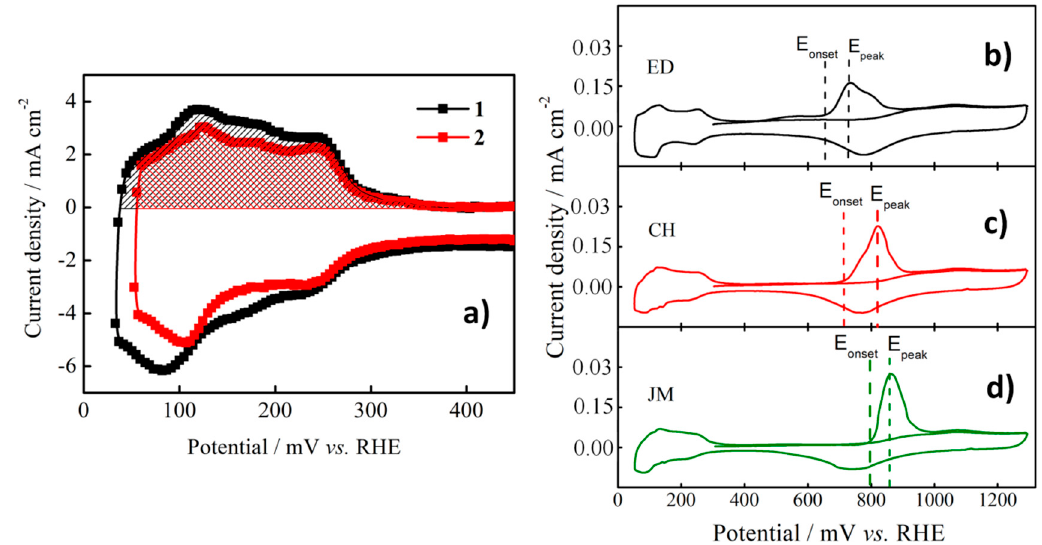
Figure 3. ( a ) Н 2 adsorption/desorption range of cyclic voltammogram (CV) curves of Pt/C (sample CH) in 0.5 М H 2 SO 4 , N 2 atmosphere, potential ranges 0.03–1.3 V (1), 0.05–1.3 V vs. the